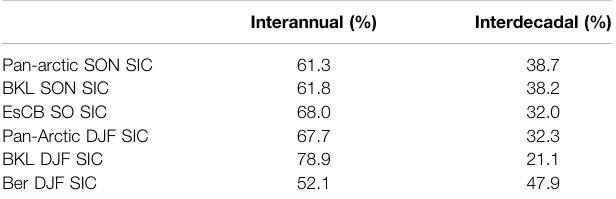
TABLE 1 | Explained variance of interannual and interdecadal components of raw SIC indices.